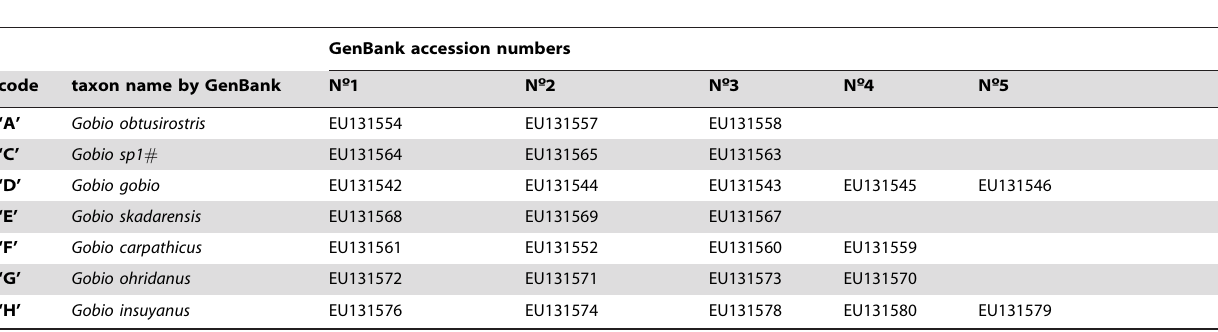
Table 2. GenBank haplotypes used for the network computation. Numbers (N o– ) of haplotypes correspond with the numbers displayed in Figure